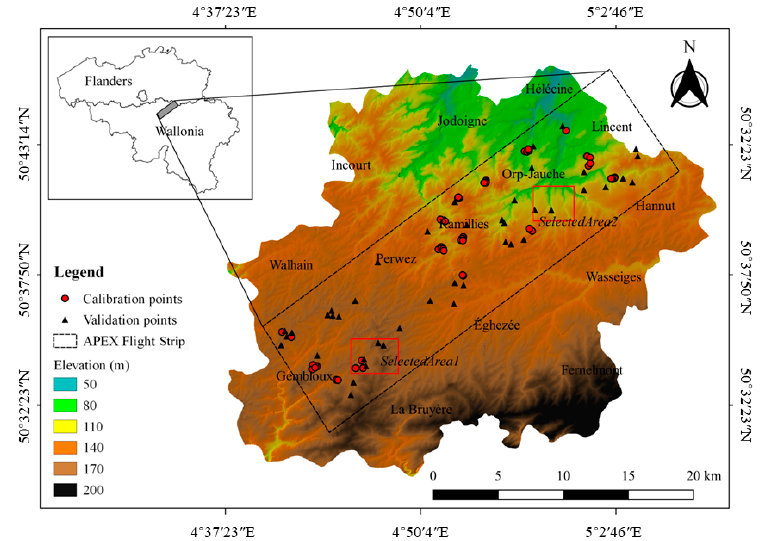
Figure 1. Location of the study region over which the APEX hyperspectral images (dashed rectangle) were acquired, and calibration and validation samples were collected. The red rectangles are the two representative areas selected for the spatial analysis of aggregate stability.